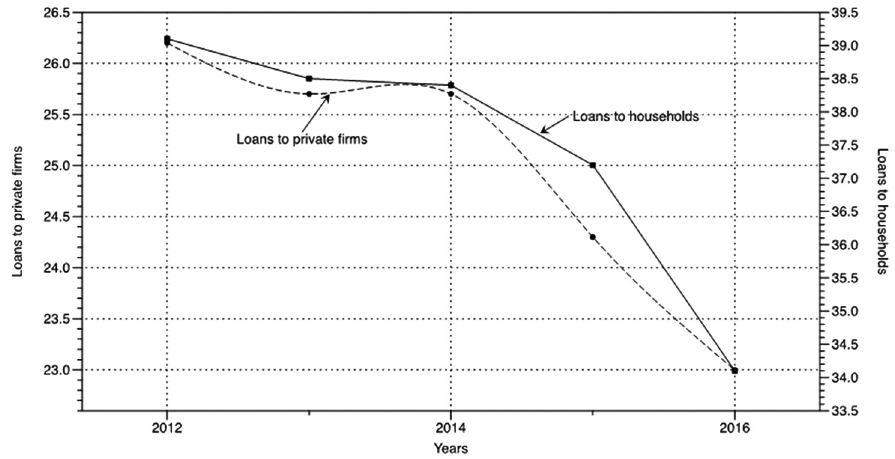
Figure 2. Loans to Households and Private Enterprises (% of GDP) 2012−2016 (source: CEE Banking Sector Report,